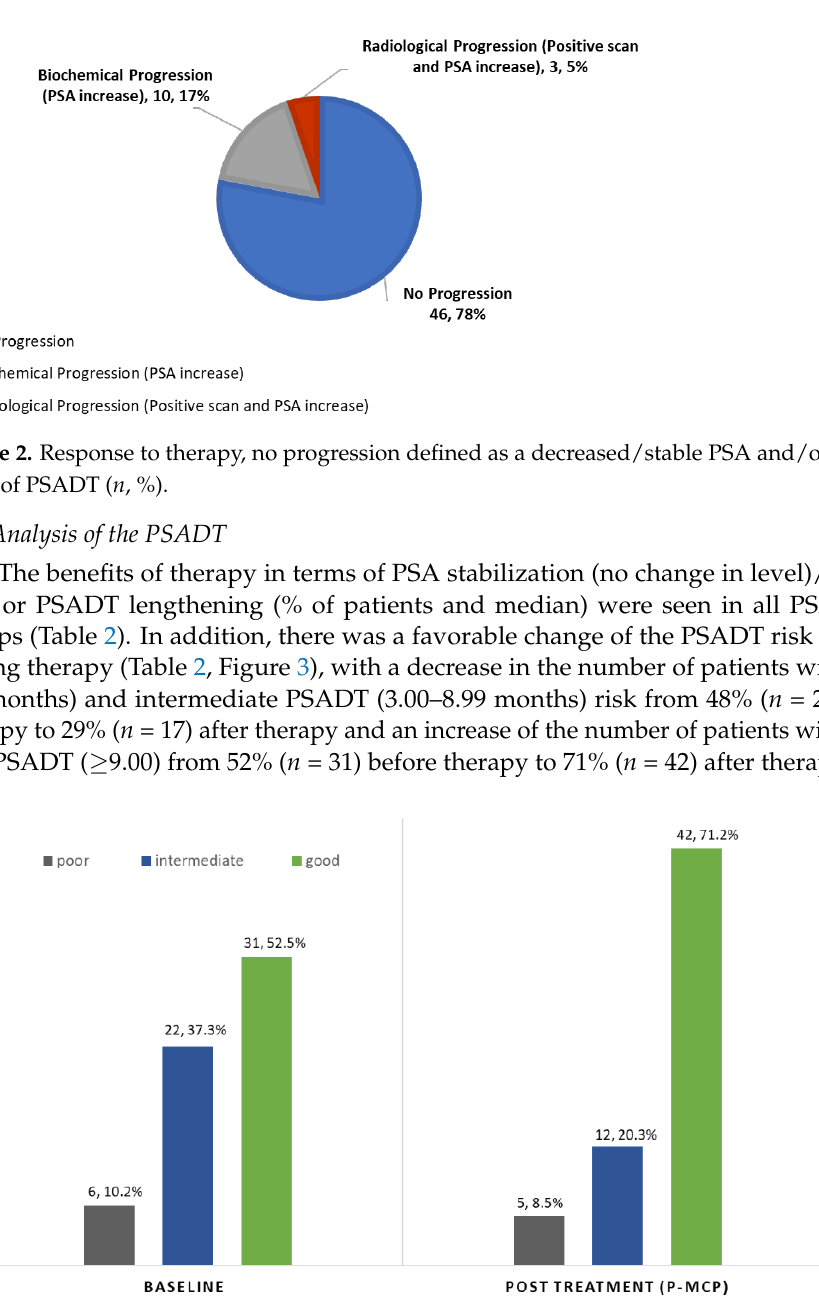
Overall, 27% of patients ( n = 16) favorably changed their PSADT risk grouping. Spe-